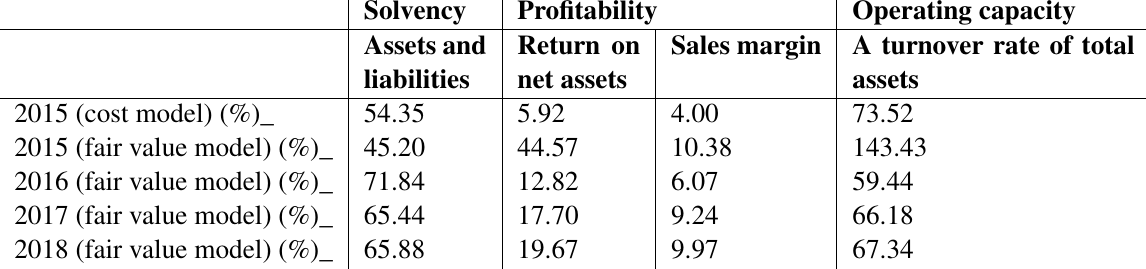
Table 4 List of impacts of changes in measurement mode on financial